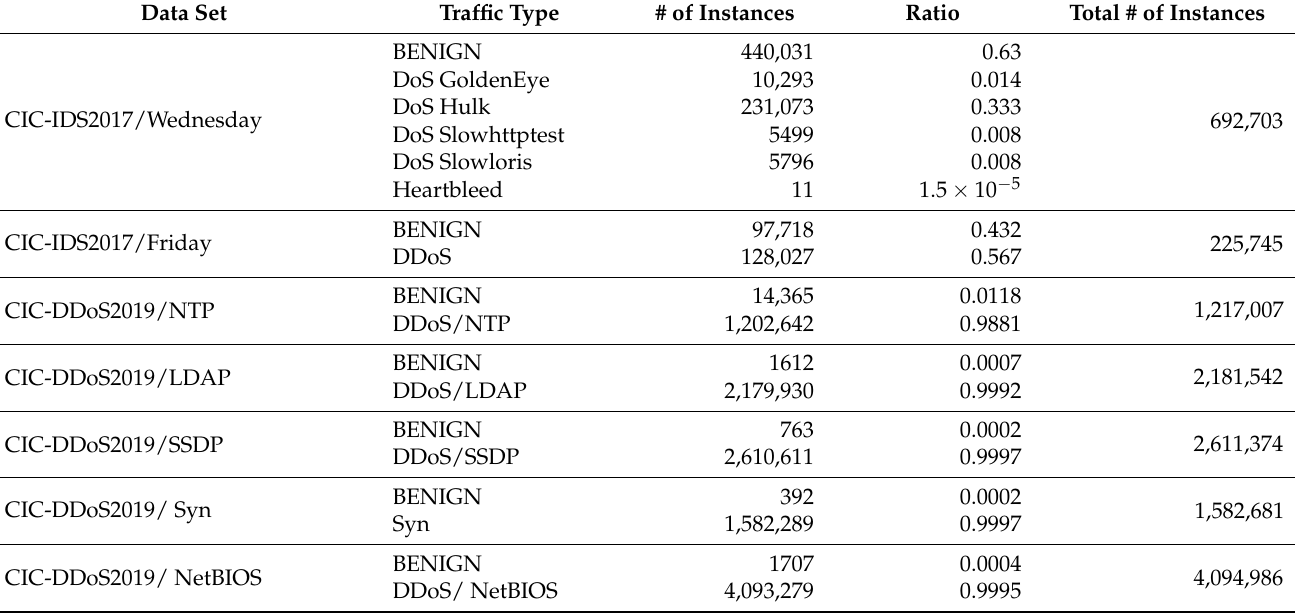
Table 1. CIC-IDS2017 and CIC-DDoS2019.